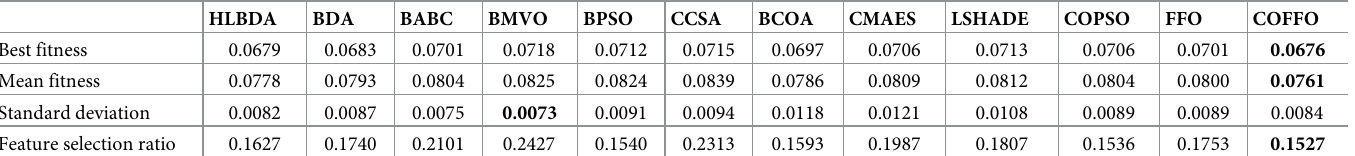
Table 15. The result of the best fitness value, mean fitness value, standard deviation of fitness value and feature selection ratio of algorithms on the COVID-19 dataset. HLBDA Best